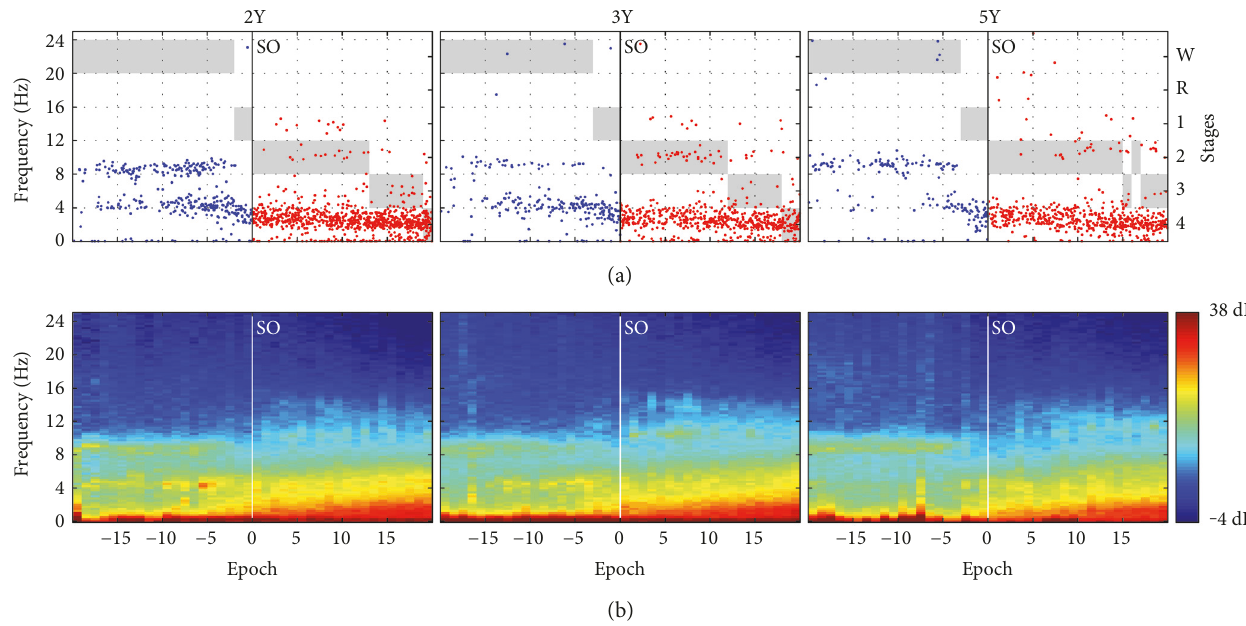
Figure 6: Oscillatory events and spectrograms at the transition into sleep, 10 min prior to and after sleep onset ( ± 20 30s epochs). Sleep onset was de fi ned as the fi rst occurrence of stage 2. (a) Occurrence of oscillatory events (frequency axis on left) pooled across the eight children superimposed on average sleep stages (axis on right; W: waking; R: REM sleep; 1 – 4: NREM sleep stages 1 – 4). (b) Average spectrograms ( n = 8 ). Spectra are color coded on a logarithmic scale (0 dB =1 μ V 2